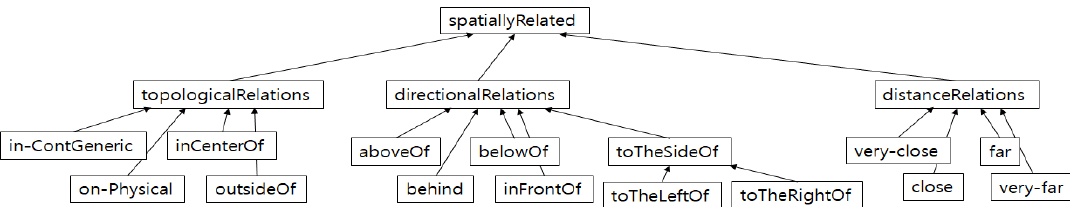
Figure 3. An example of 3D spatial relations between objects.